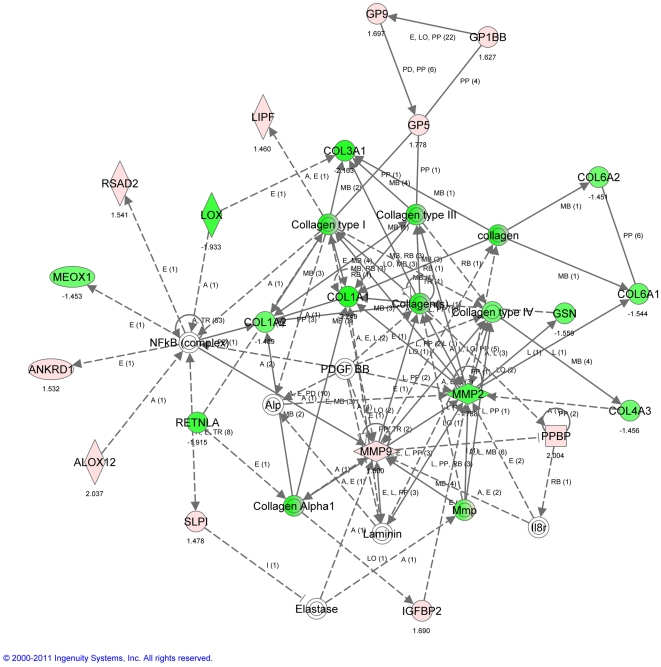
Ingenuity Pathway Analysis (IPA) of transcriptomic patterns without PNX.Top network illustrates transcripts that are significantly modulated in a whole lung analysis of 9 vs. 3 month mice (no surgery). Green indicates down-regulated transcripts, red indicates up-regulated transcripts. Key: The node shapes denote - enzymes  phosphatases  kinases  peptidases  G-protein coupled receptors  transmembrane receptors  cytokines  growth factors  ion channels  transporter  transcription factor  other .